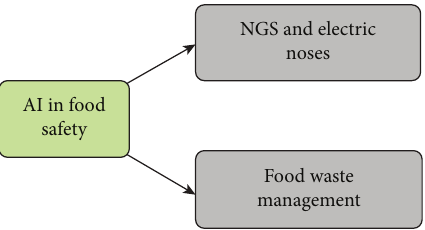
Figure 7: Artificial intelligence in food